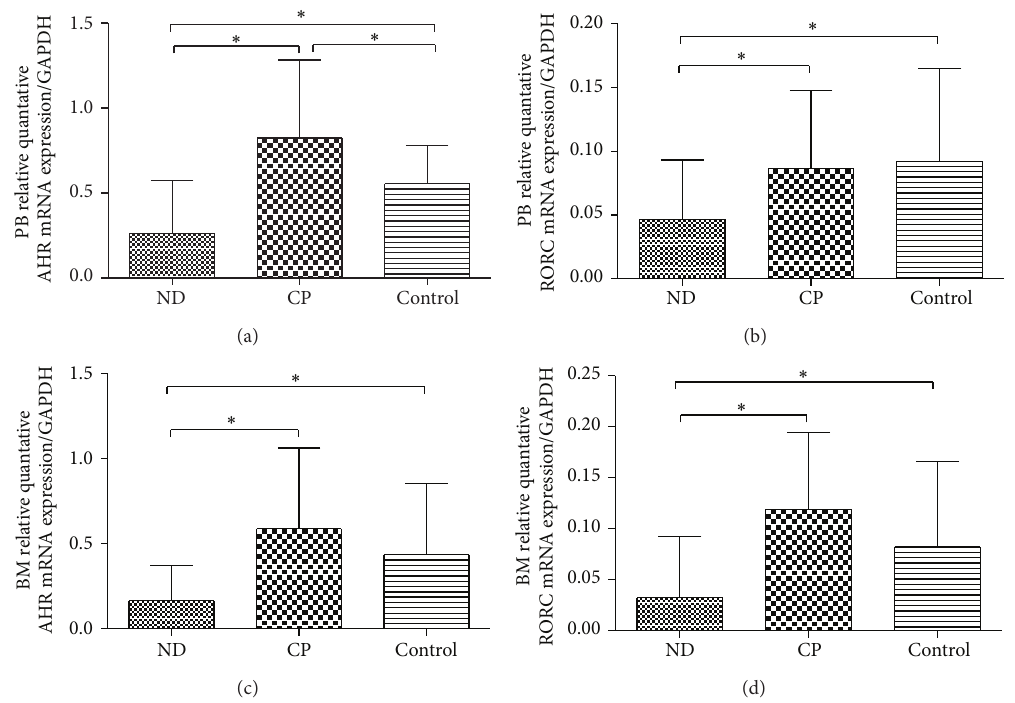
Figure4:ExpressionofAHRandRORCmRNAinCMLpatientsandhealthycontrols.(a)TheexpressionofPBAHRmRNAwassignificantly decreased in ND patients compared to CP ( 𝑃 = 0.000 ) and healthy controls ( 𝑃 = 0.017 ). (b) The expression of PB RORC mRNA was significantly decreased in ND patients compared to CP ( 𝑃 = 0.048 ) and healthy controls ( 𝑃 = 0.034 ). (c) The expression of BM AHR mRNA was significantly decreased in ND patients compared to CP ( 𝑃 = 0.000 ) and healthy controls ( 𝑃 = 0.024 ). (d) The expression of BM RORC mRNA was significantly decreased in ND patients compared to CP ( 𝑃 = 0.000 ) and healthy controls ( 𝑃 = 0.047 ).